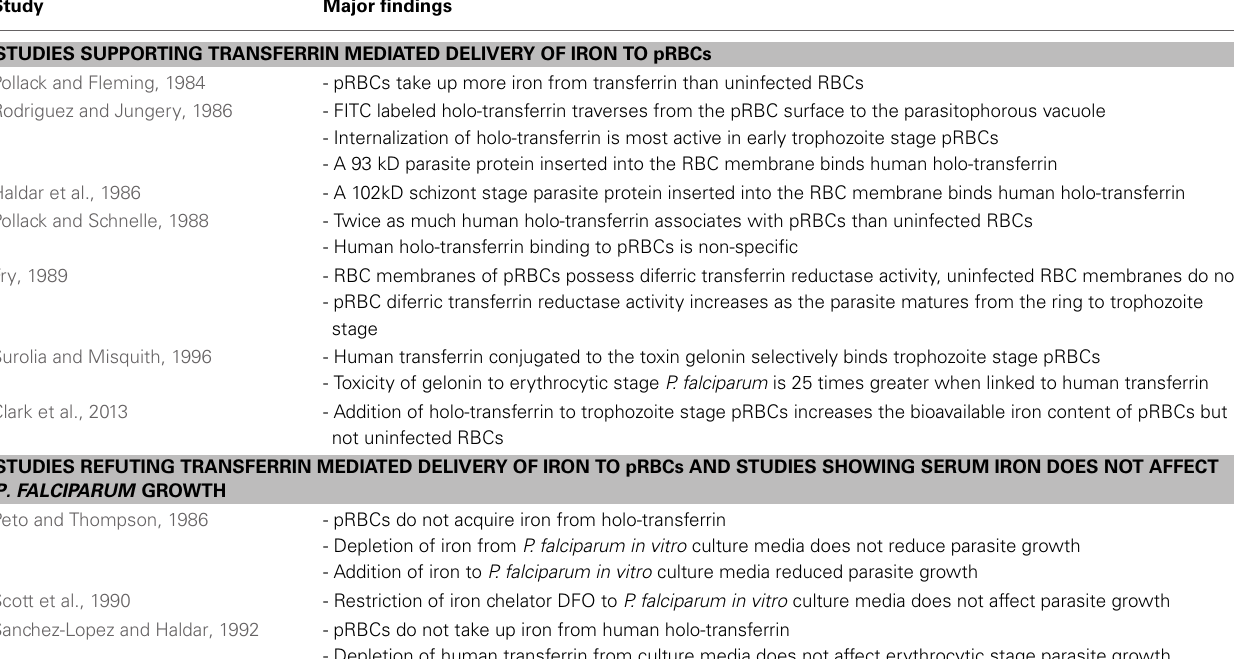
Table 2 | Relationship between host serum iron and P. falciparum.